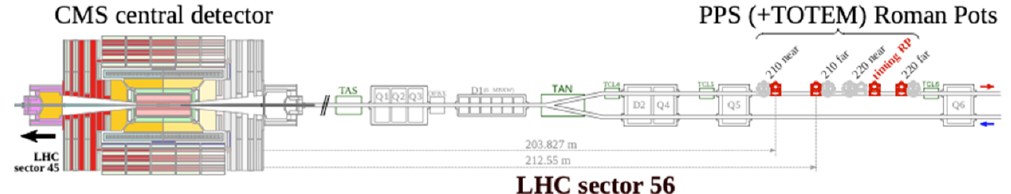
Figure 1: Experimental setup of PPS in